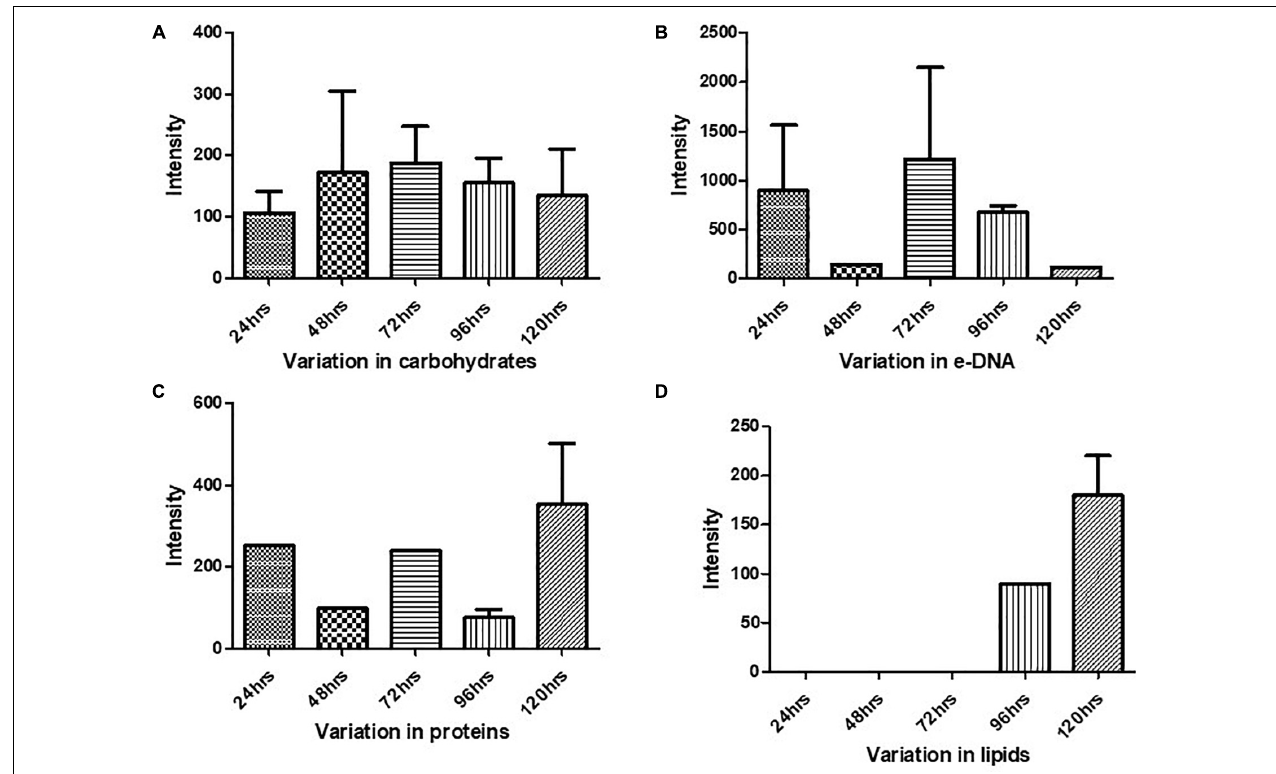
FIGURE 5 | Variation in the biomolecules during the cultivation time period from 24 to 120 h procured through SERS: (A) carbohydrates, (B) e-DNA, (C) proteins, and (D) lipids. All the interpreted peaks are exclusive for each of the represented biomolecules.